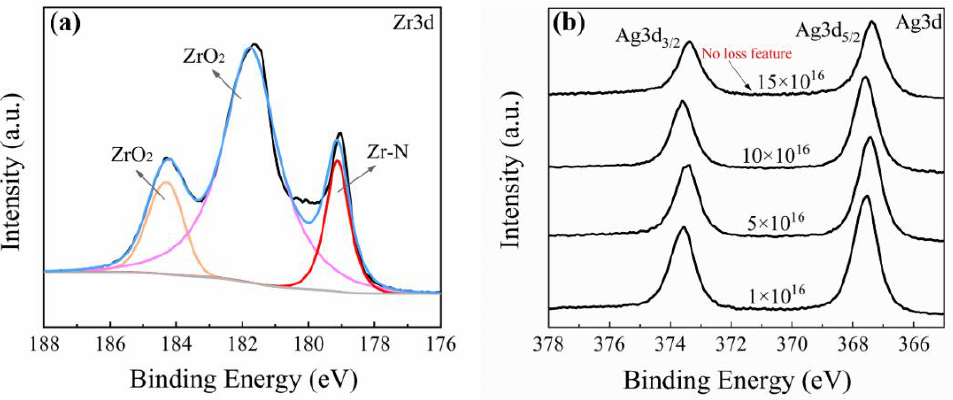
Figure 4. ( a ) XPS spectra of Zr-3d from ZrN/Ag 2 O gradient composite coating; ( b ) XPS spectra of Ag-3d from different doses of ZrN/Ag 2 O gradient composite coatings.